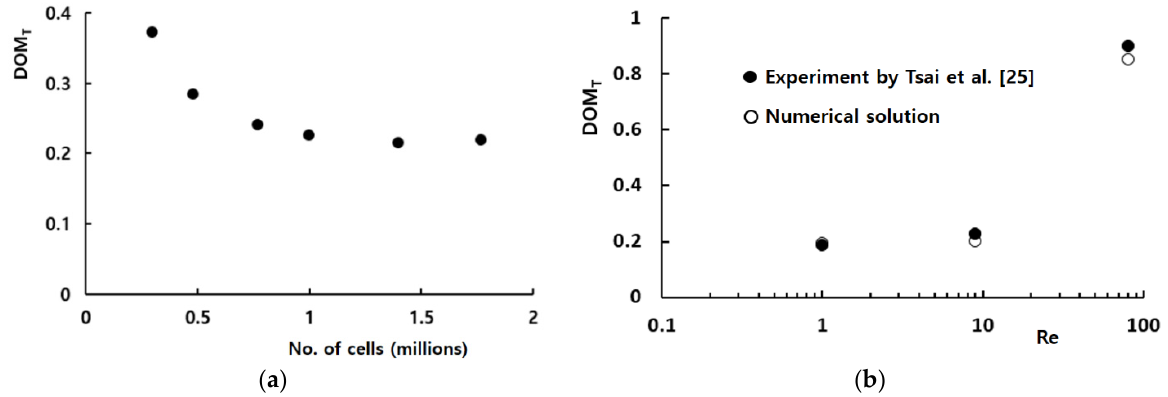
Figure 4. Validation of numerical solution. ( a ) Grid dependence of the numerical solution. ( b ) DOM vs. Re .